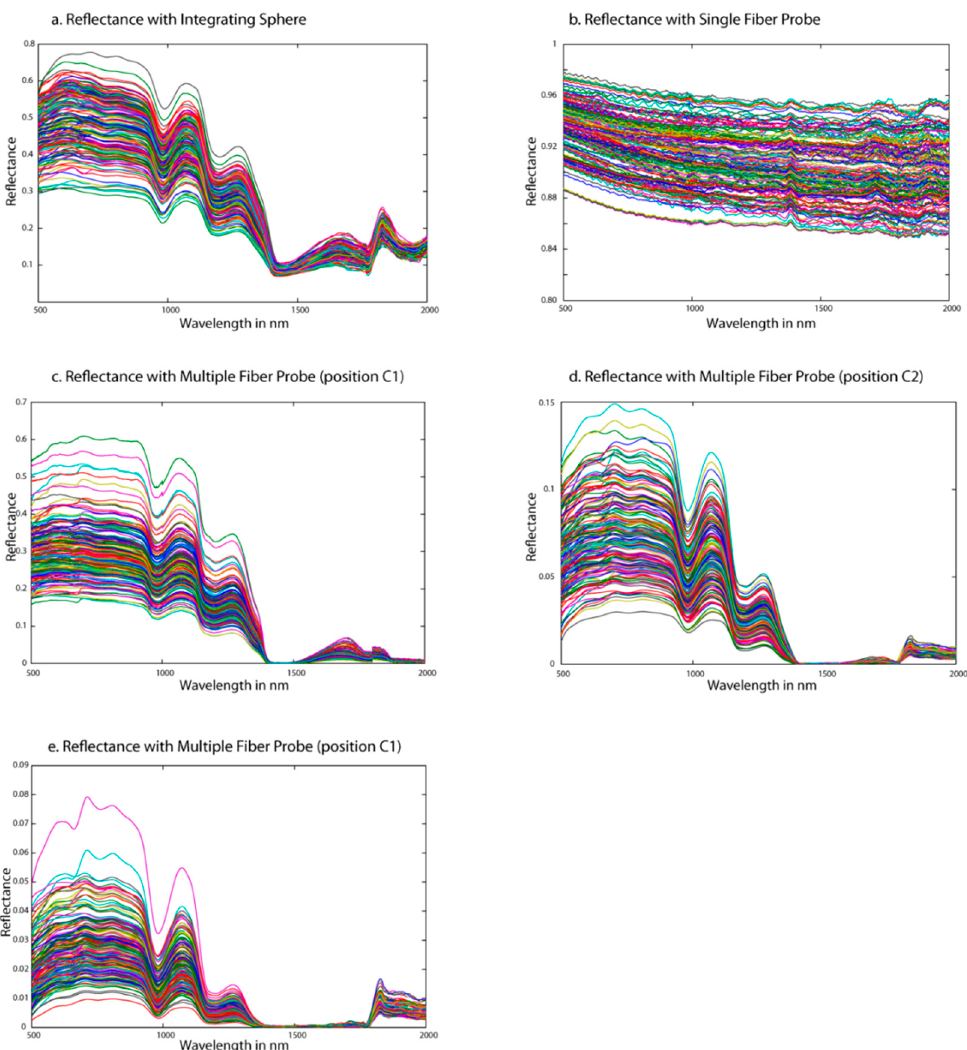
Figure 3. Raw reflectance spectra measured with integration sphere ( a ), single-fiber probe ( b ) and a multiple fiber probe respectively with a distance of 600 μ m ( c ),1200 μ m ( d ) and 1800 μ m ( e ).